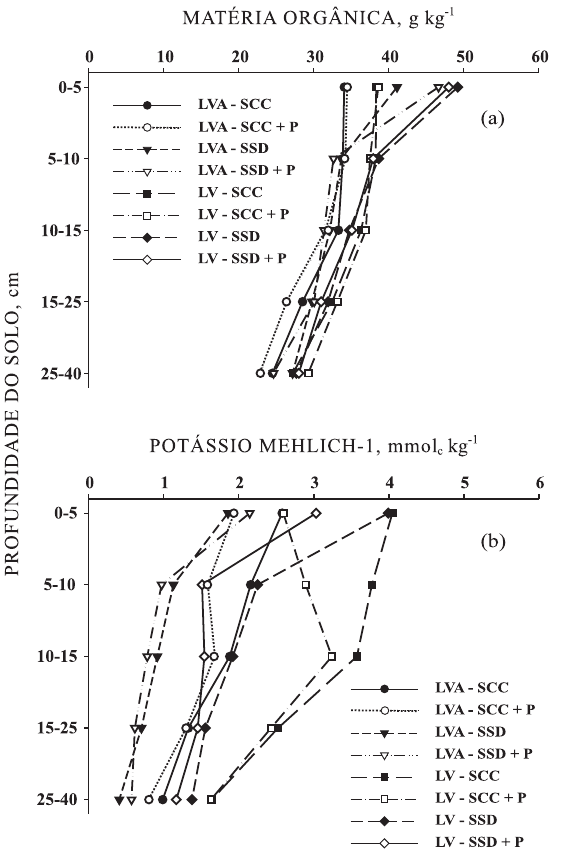
Figura 3. Teores de matéria orgânica (a) e de potássio (b) disponível nos solos LVA e LV sob dois sistemas de manejo (SCC e SSD), com e sem fertilizante fosfatado